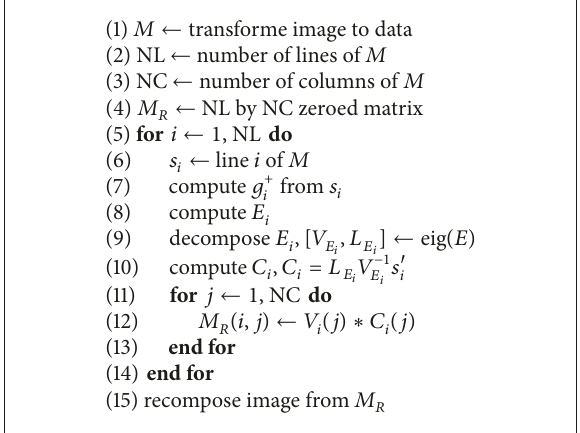
Algorithm 1: Pseudocode for decomposition and